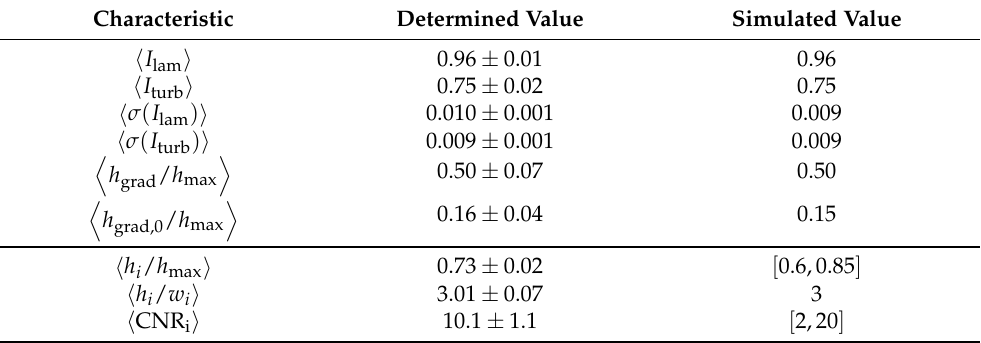
Table 1. Important characteristics of the thermograms of rotor blades (first section) and the turbulent wedges (second section) determined in real thermograms of wind turbines in motion. All thermo- grams were normalized to a range of 0 to 1 in arbitrary intensity units. The standard deviation of the mean is given as the measurement